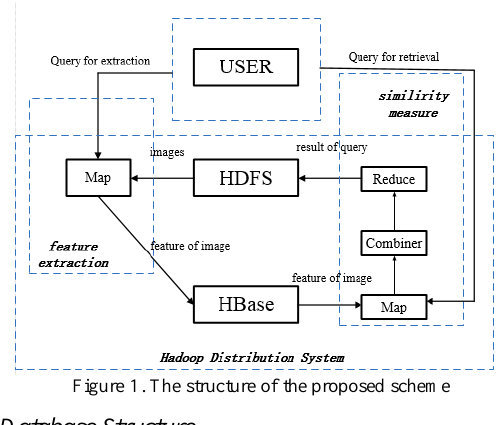
Figure 1. The structure of the proposed scheme